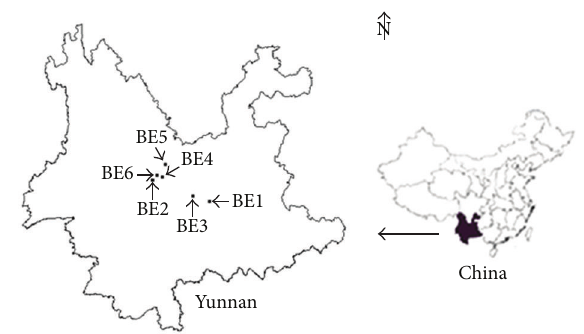
Figure 1: Localization of the sampling sites (dot) of Boletus edulis in central Yunnan, China.